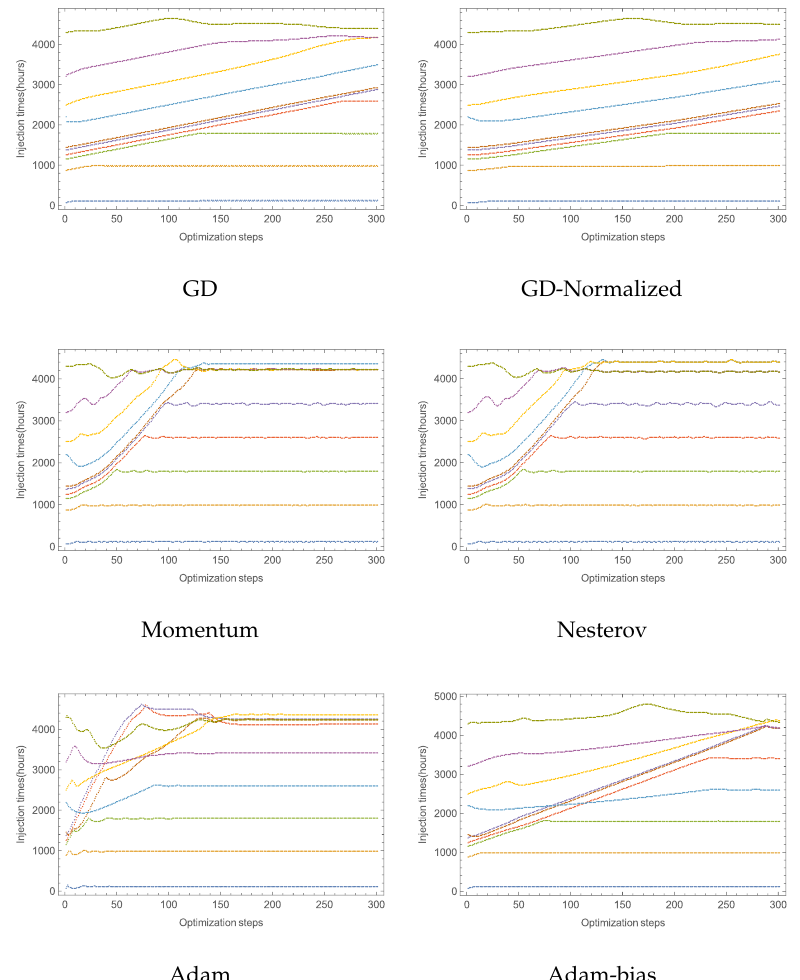
Figure 3. Comparison between the distinct schedule evolution of each GD variant ( T max =